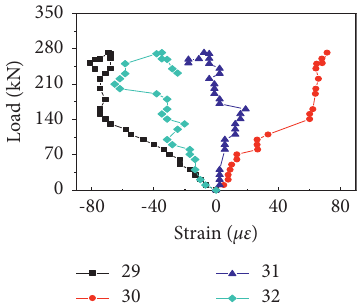
Figure 21: Load-strain curves at measuring points 29 to 32 of test piece 2-A.